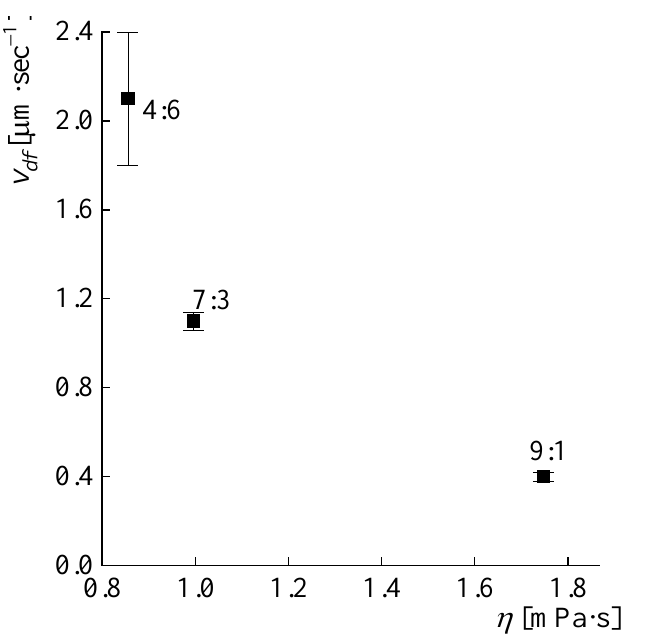
Figure 6. Dependence of the forming solution diffusion rate into the solvent on its viscosity. DMSO:MeOH ratios are 4:6, 7:3, 9:1; KOH is 100 wt% of the polymer.